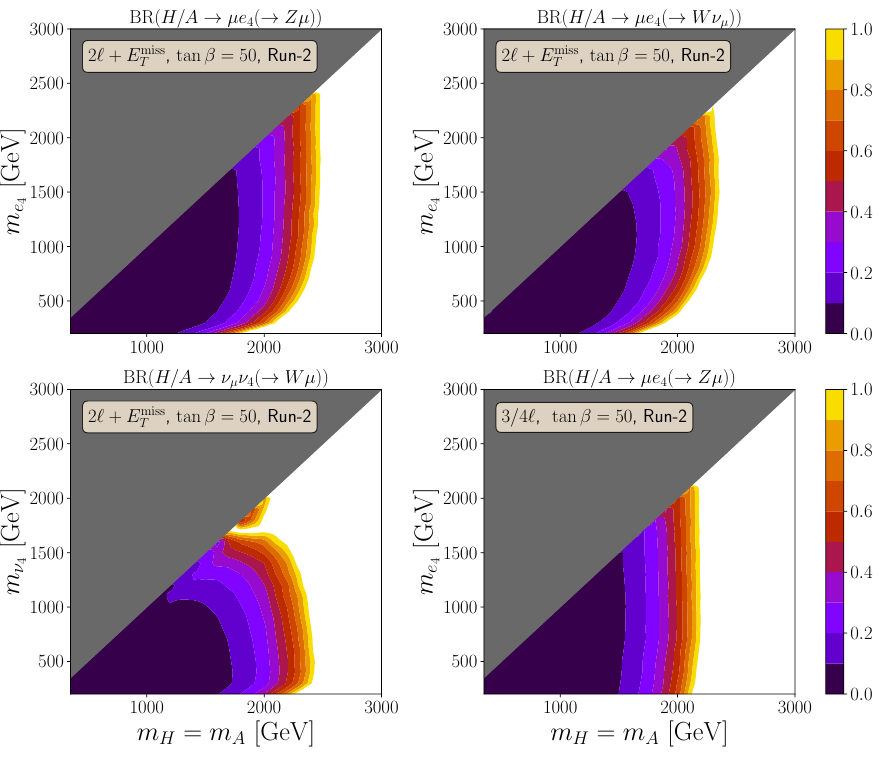
Figure 9 . Current upper bounds on the branching fractions when tan β = 50